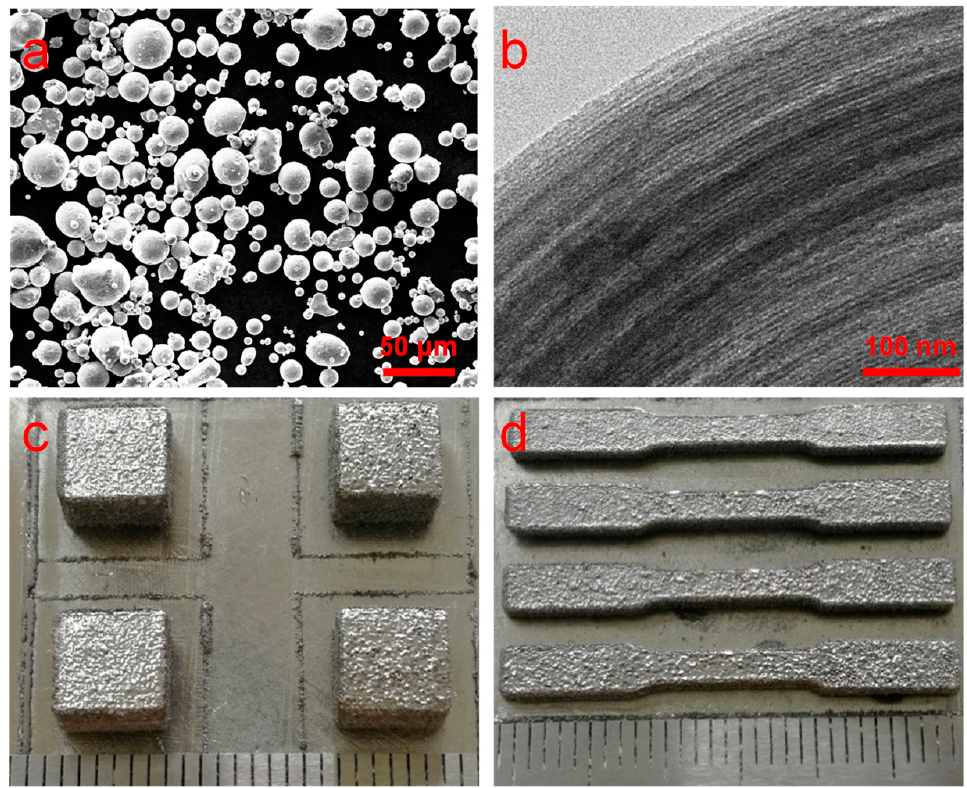
Table 1. Physical and chemical parameters of